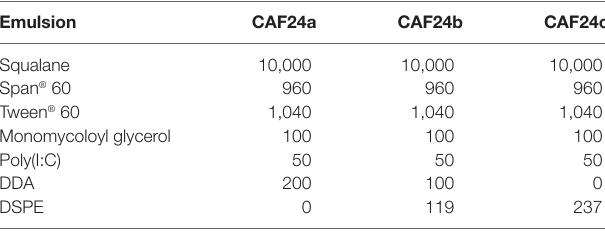
Table 1 | The composition of the emulsions CAF24a–c with different ratios of DDA and DSPE. emulsion